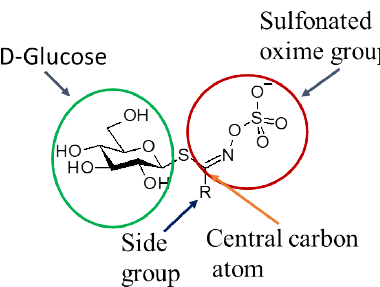
Fig. 6: General structure of glucosinolates